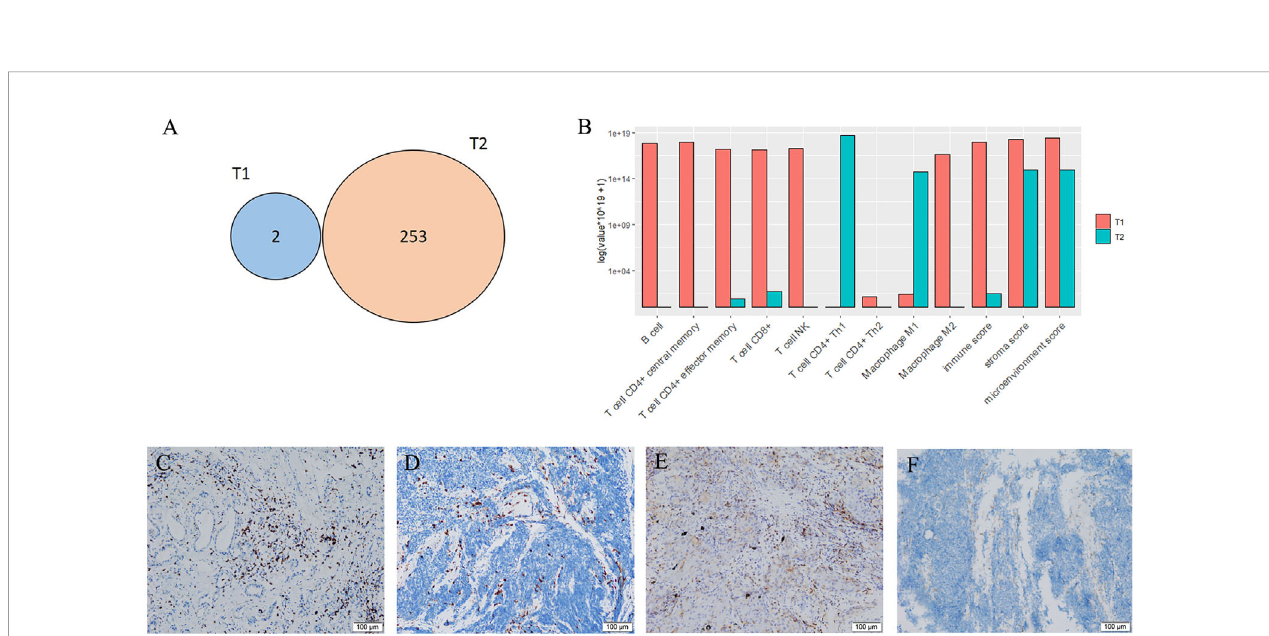
FIGURE 3 | Mutations and tumor microenvironments. (A) Overlap of non-silent mutations of adenocarcinoma (T1) and small cell lung cancer (T2) samples from the same patient. (B) Fractions of in fi ltrating cells. (C) CD8 + T cells of T1. (D) CD8 + T cells of T2. (E) CD4 + T cells of T1. (F) CD4 + T cells of